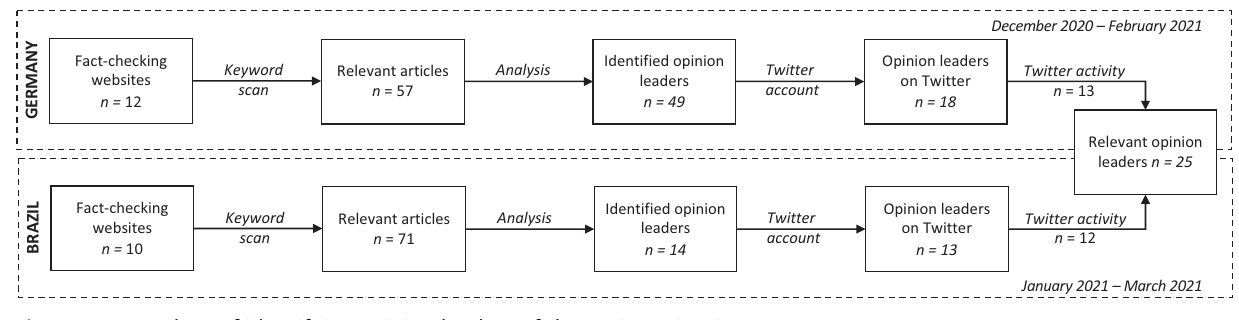
Figure 1. Procedure of identifying opinion leaders of the anti‐vaccination movement.